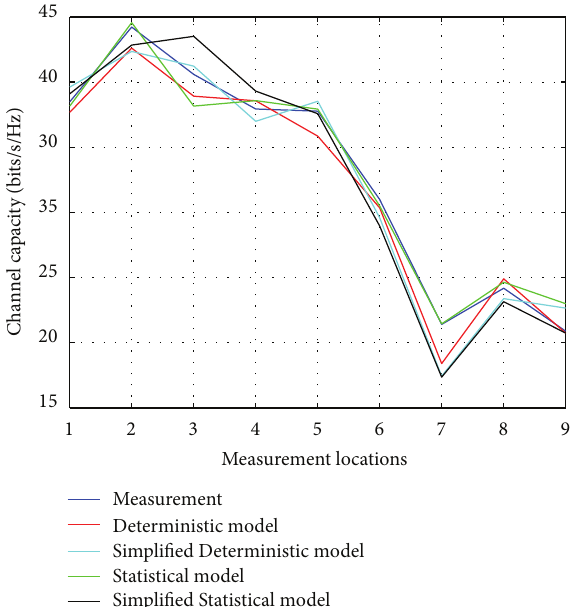
Figure 12: Distribution of received power of channel elements in downlink.